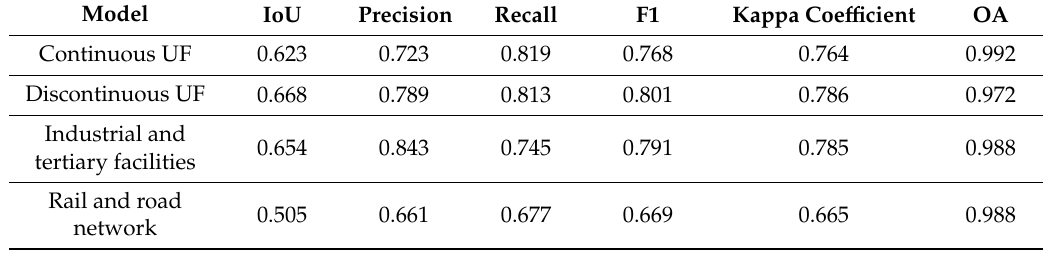
Table 9. Evaluation metrics computed over the validation set for each class. Table 8. Evaluation metrics computed over the validation set for each class.